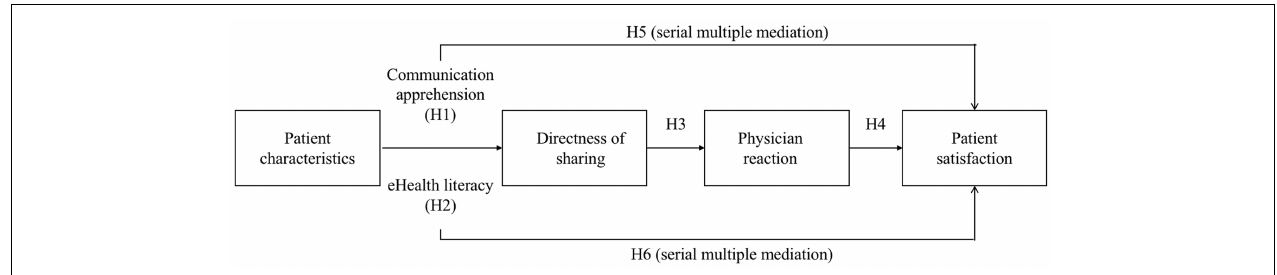
FIGURE 1 | Schematic overview of the theoretical model and study